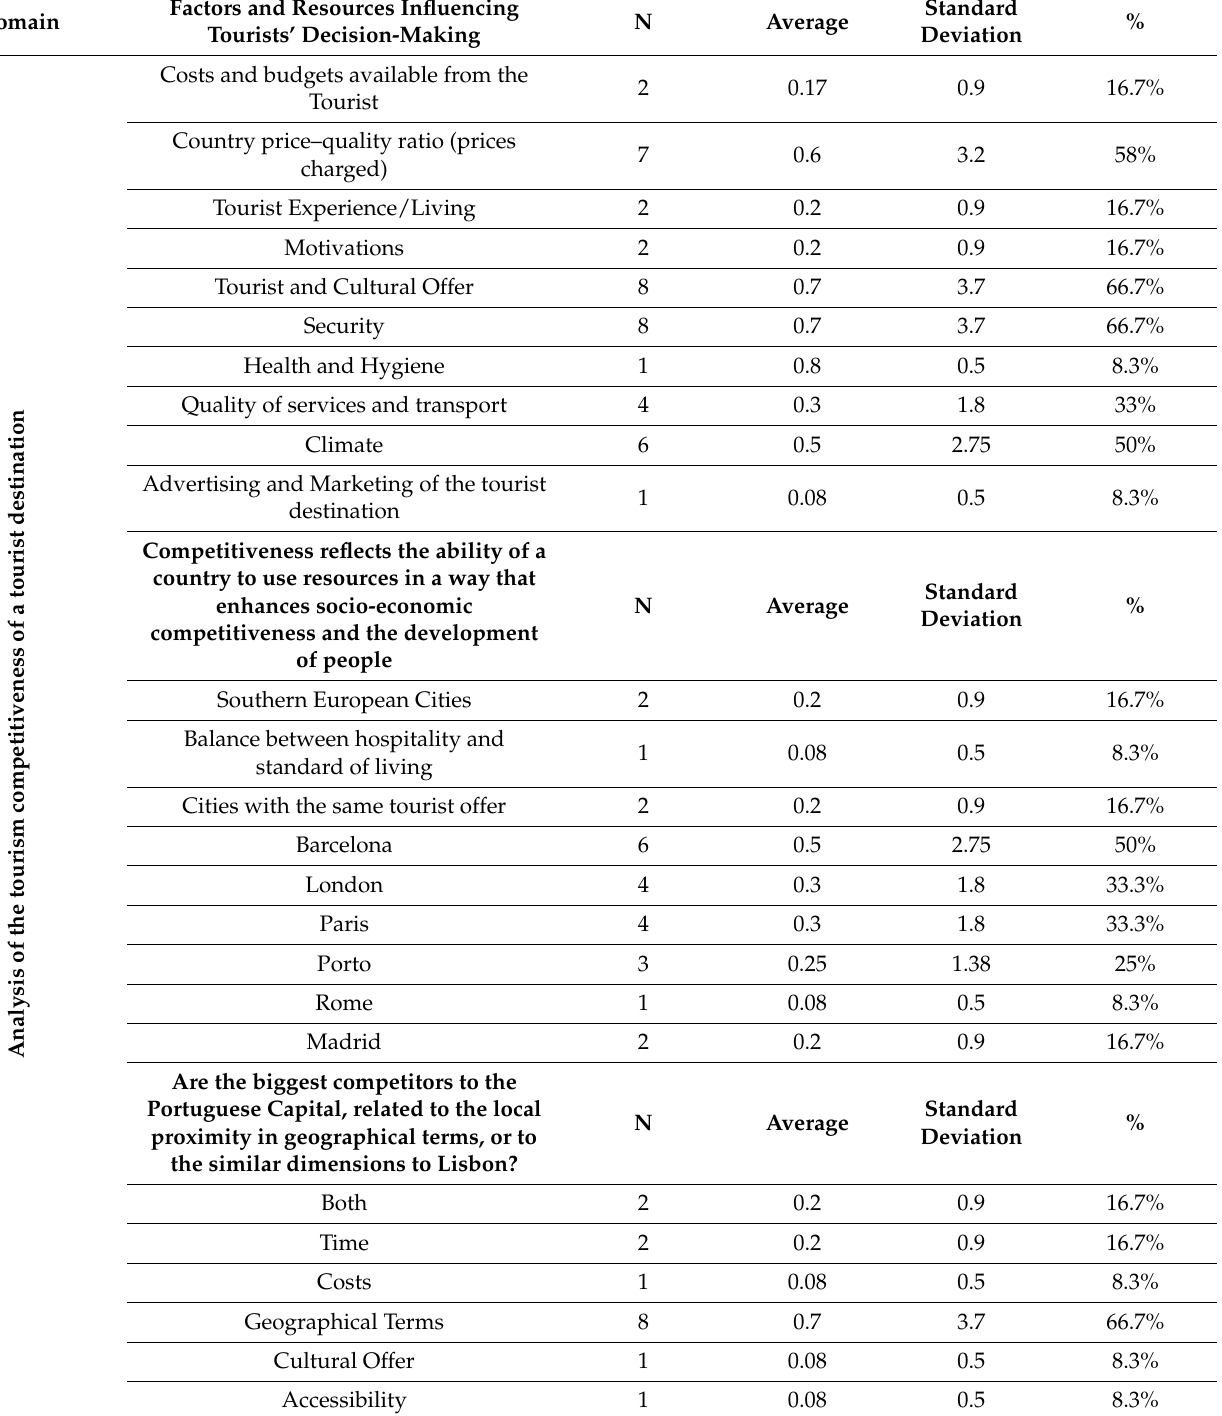
Table 5. Results of the first round of interviews—domain, analysis of tourism competitiveness of a tourist destination. Source: Elaborated by the